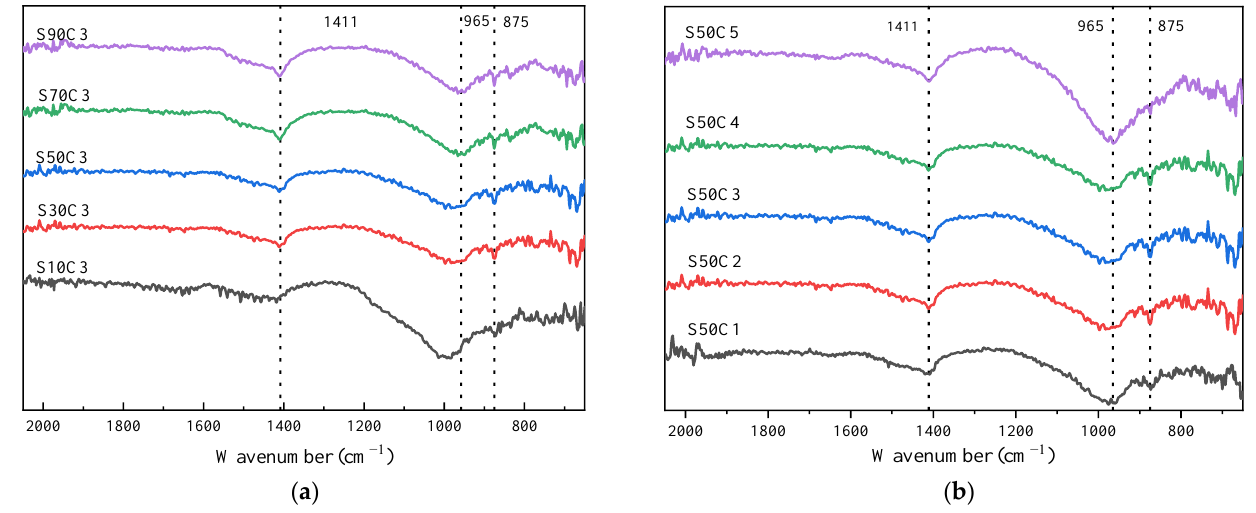
Figure 6. FT-IR spectra analysis of alkali-activated composite cementitious materials: ( a ) slag content; ( b ) activator concentration.